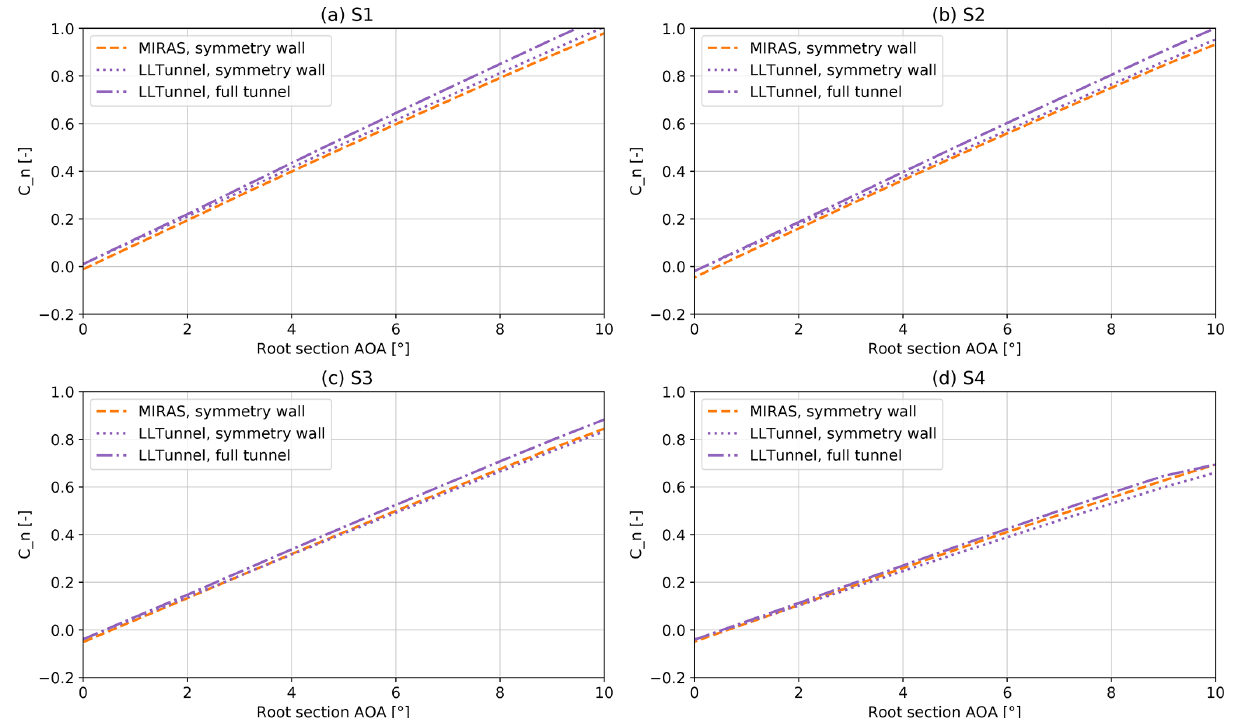
Figure 10. The graphs show MIRAS and LLTunnel C n values as function of root section AOA for blade sections corresponding to the measurement locations on the wing. (a) Section 1. (b) Section 2. (c) Section 3. (d) Section 4. MIRAS models the wing on a symmetry wall while LLTunnel models both that configuration and the full-tunnel configuration.